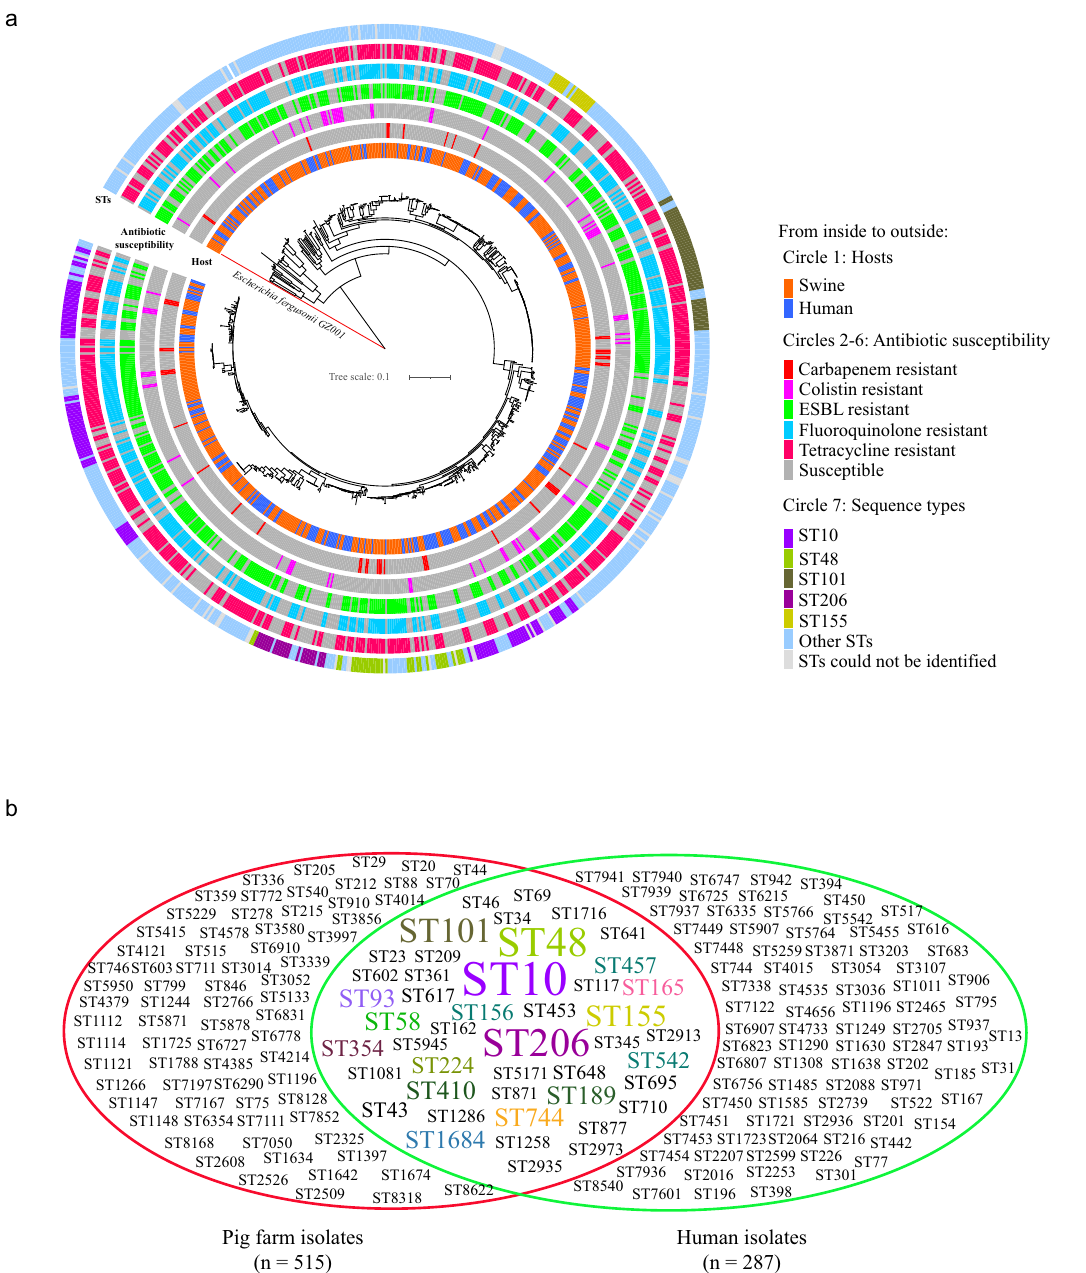
Fig. 5 Phylogenetic trees of 515 multidrug-resistant E. coli isolates from pig farms together with 287 publicly available draft genomes of human commensal E. coli across China. a Circular tree showing the phylogenetic relationship of the 802 E. coli isolates. The tree was generated based on the core genome SNPs using the snippy-multi program implemented in Snippy v 4.4.0 (https://github.com/tseemann/snippy), and was rooted on the E. fergusonii sequence. The snippy based tree was inferred using FastTree2, and was visualized using the Interactive Tree Of Life (iTOL v.5). Raw data for the Snippy tree and its annotation codes are provided in Supplementary Data 12; b Venn diagram showing the shared and unique sequence types between pig farm- originating E. coli and human commensal E. coli